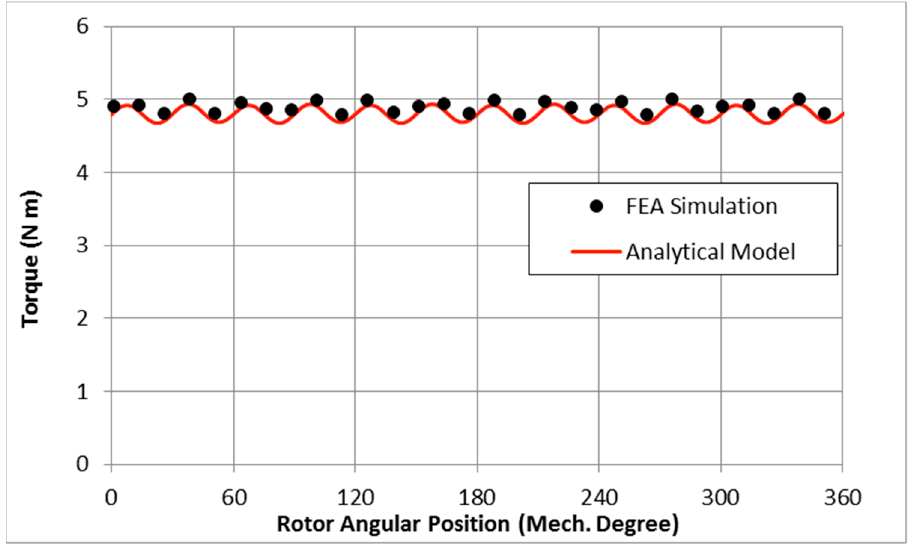
Figure 12. Analytical and MotorSolve FEA Predictions of Electromagnetic in the 12 s/10 p Conventional Machine (average deviation: 1.6%).